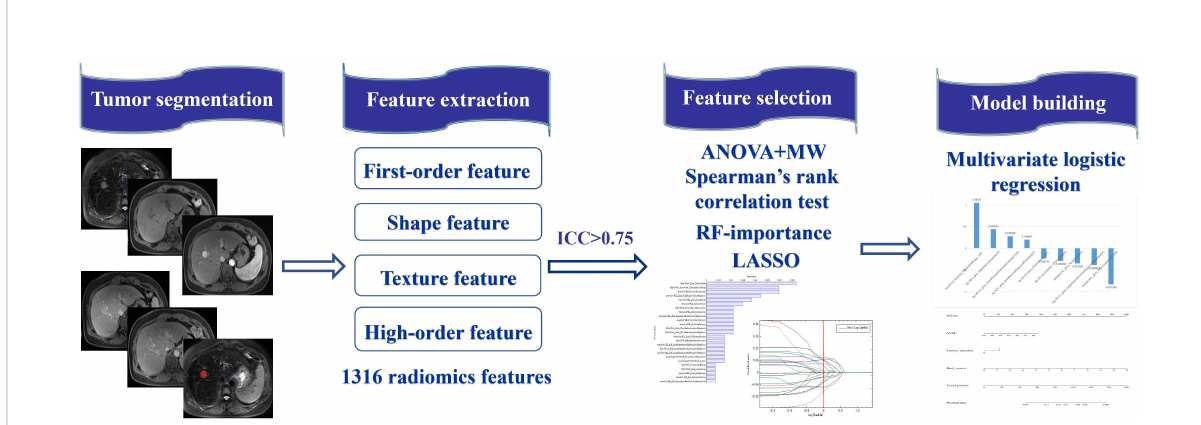
FIGURE 1 The work fl ow of radiomics in the current study. Tumor 2D segmentation was performed on mpMRI and applied to extract 1316 radiomics features, including fi rst-order feature, shape feature, texture feature and higher-order feature. After interobserver agreement analysis, the most predictive radiomics features were selected via the Anova+MW, Spearman ’ s rank correlation test, RF-importance, and LASSO analysis. The radiomics model was established by multivariate logistic regression analysis. The predictive nomogram was constructed based on the radiomics score and clinical